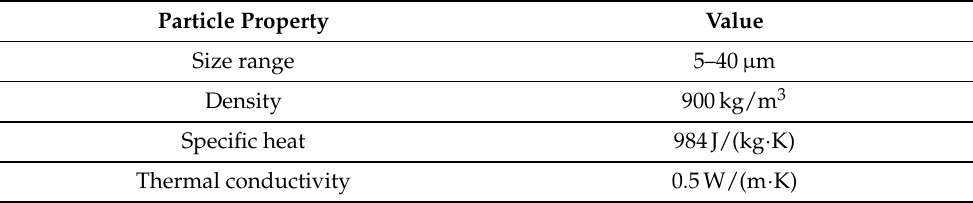
Table 1. Physical properties of the added wax particle.